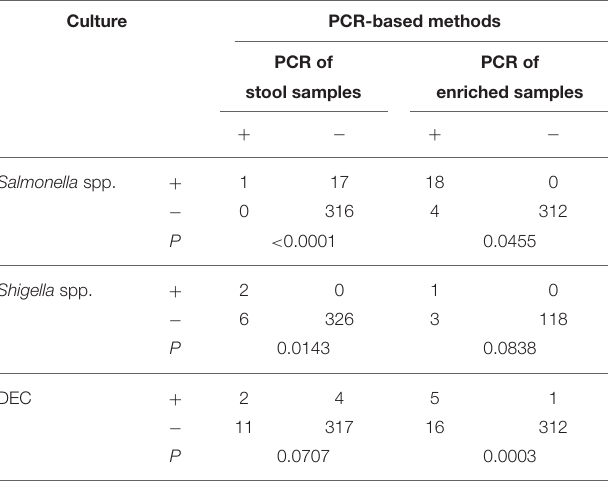
TABLE 4 | Comparison of the detection results between PCR-based methods and culture/isolation method.